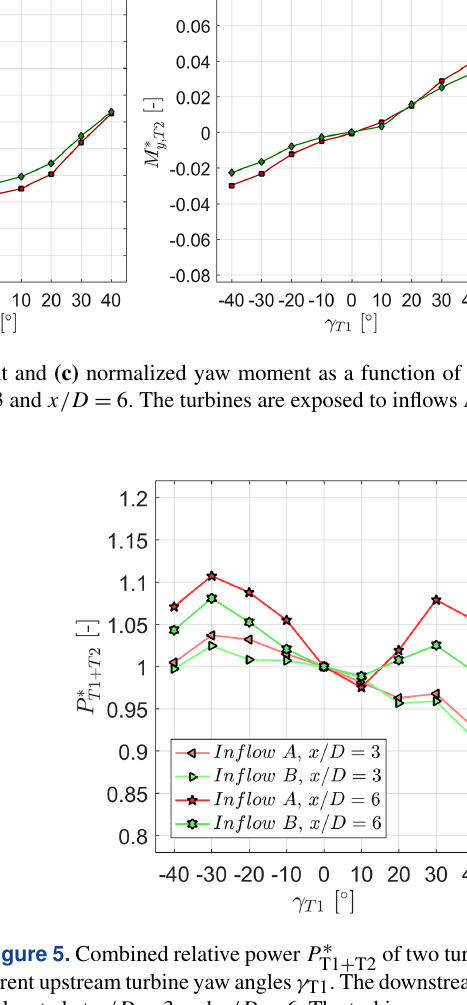
Figure 5. Combined relative power P ∗ ferent upstream turbine yaw angles γ T1 . The downstream turbine T2 is located at x/D = 3 and x/D = 6. The turbines are exposed to in- flows A and